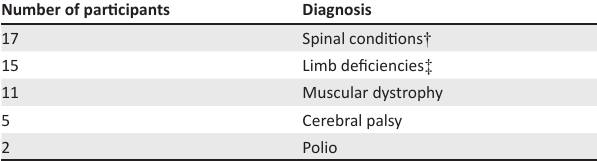
TABLE 1b: Diagnosis as provided by the host organisation. Number of